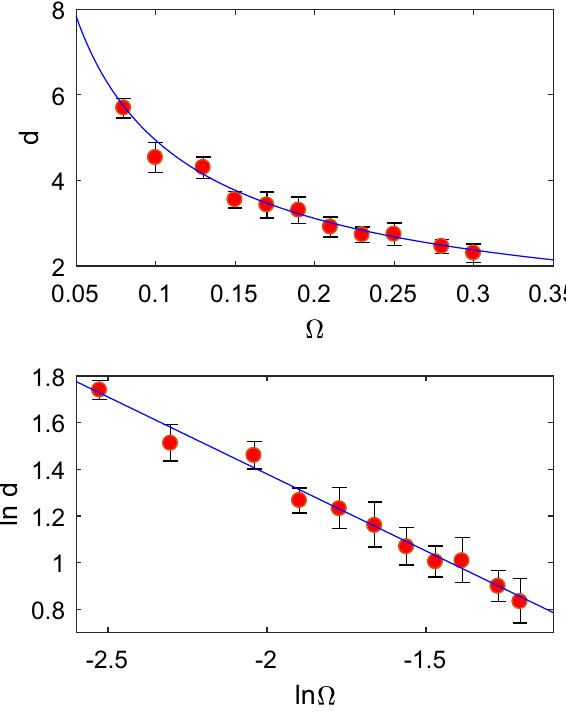
Fig. 5 (Top): the sheet distance d as a function of Ω on a Ω − d plot: Ω − 2 3 . (Bottom): the sheet distance d as a function of Ω on a d = 1 0 . 95 Log–Log plot. The straight line is the best fit to ln d = a ln Ω + b with a = − 0 . 655 ± 0 . 027 and b = 0 . 060 ± 0 .